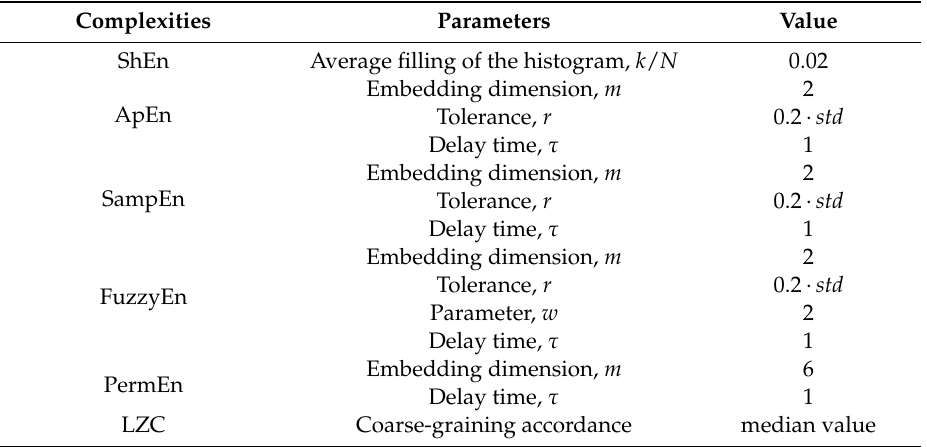
Table 3. The summary of the selected parameter values.